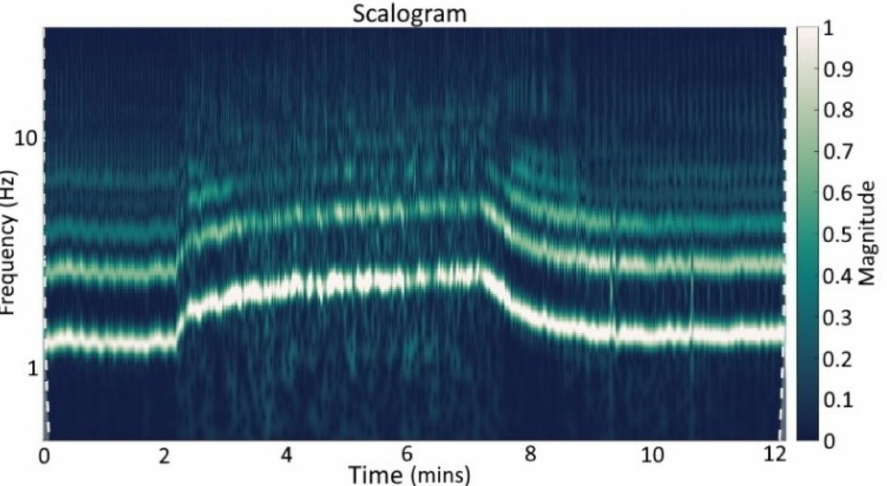
Figure 13. Scalograms of continuous 1-D wavelet transform (Morse wavelet) of dZ/dt signal during ergometry stress test after signal processing with GRU neural network (subject